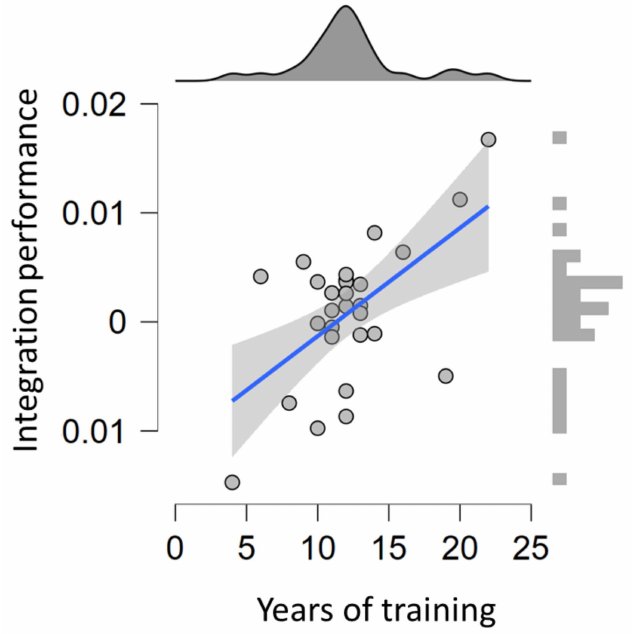
Figure 1. Associations between years of training and compensatory tracking task performance.